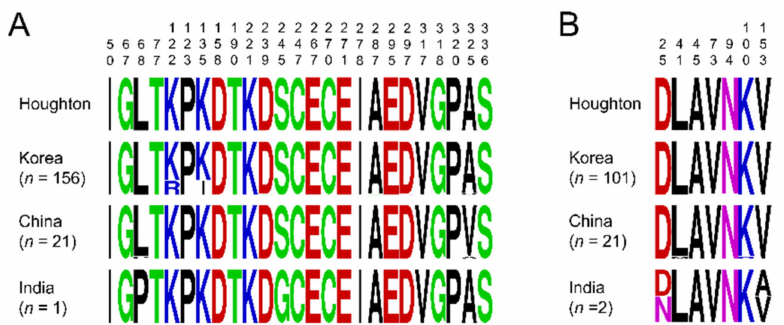
Figure 3. Comparative analysis of amino acid polymorphisms of etmic2 and etsag1 in Korean, Chinese, and Indian E. tenella isolates. ( A ) Amino acid polymorphisms in etmic2 . ( B ) Amino acid polymorphisms in etsag1 . The patterns of amino acid changes differed by country. The logo plot for each gene was constructed using the WebLogo program. The sequences of Houghton etmic2 (XM_013377912.1) and etsag1 (AJ586531.2) were used as reference sequences. Amino acid positions were marked on top of each amino acid